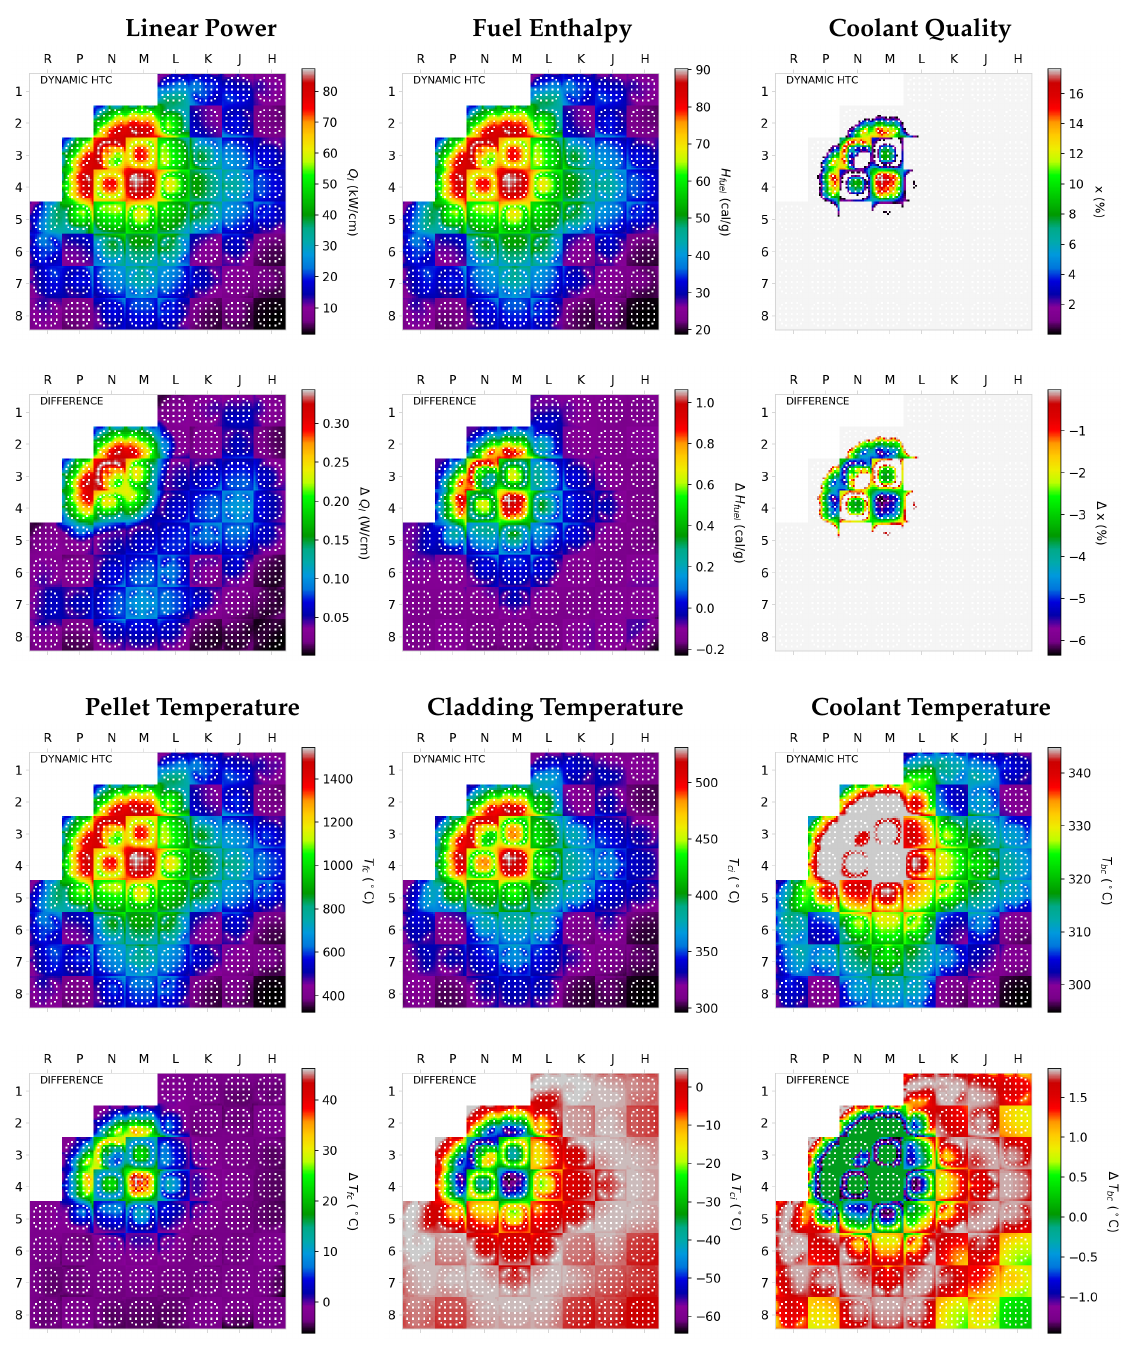
Figure 5. Radial distribution of safety parameters peaks during transient and effect of the pellet-cladding gap HTC dynamical change, simulation tolerance R tol =